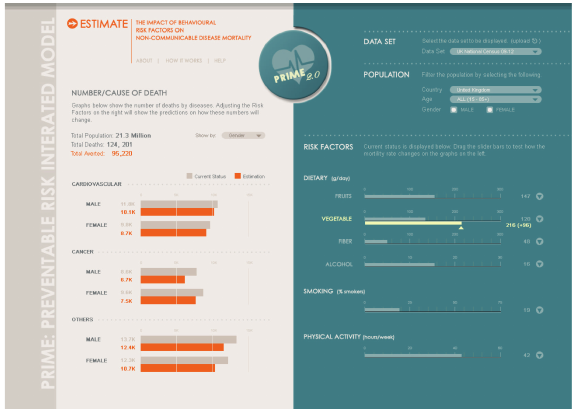
Figure 3: Overall layout of the main page in the PRIME web application. Input factors are set on the right, and outcomes are returned on the